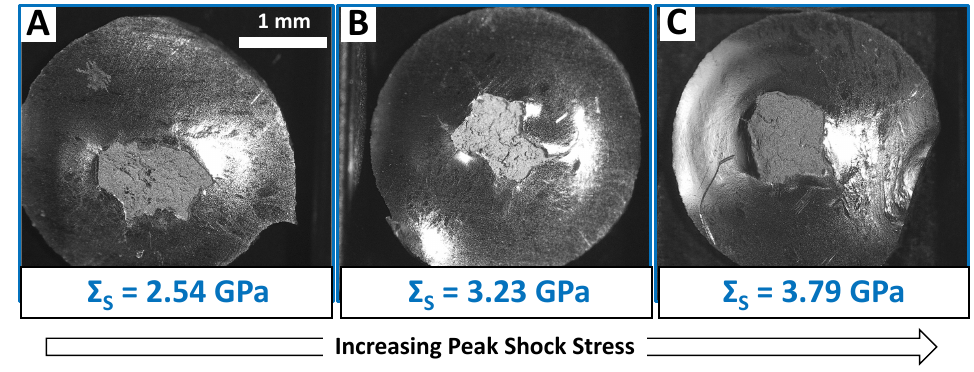
Figure 6. Macroscopic damage morphology with increasing Σ S . Sample 9A ISO ED macroscopic free-surface spall damage at ( A ) low, ( B ) moderate, and ( C ) high Σ S .